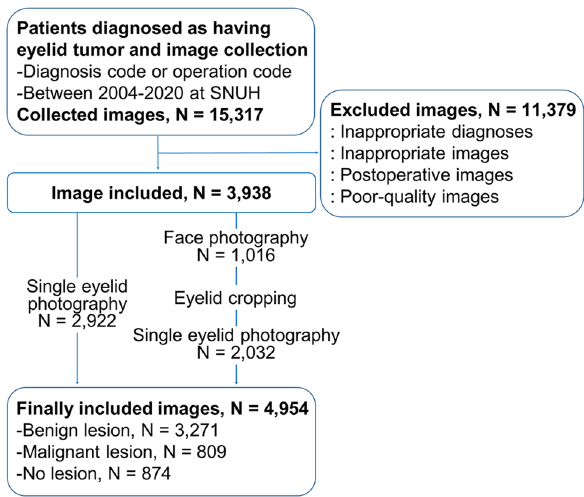
Figure 1. Flow diagram of eyelid image dataset